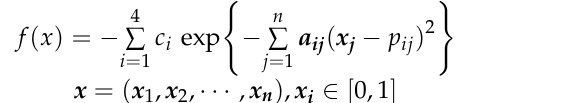
Table 4. Parameters of the Hartman function.